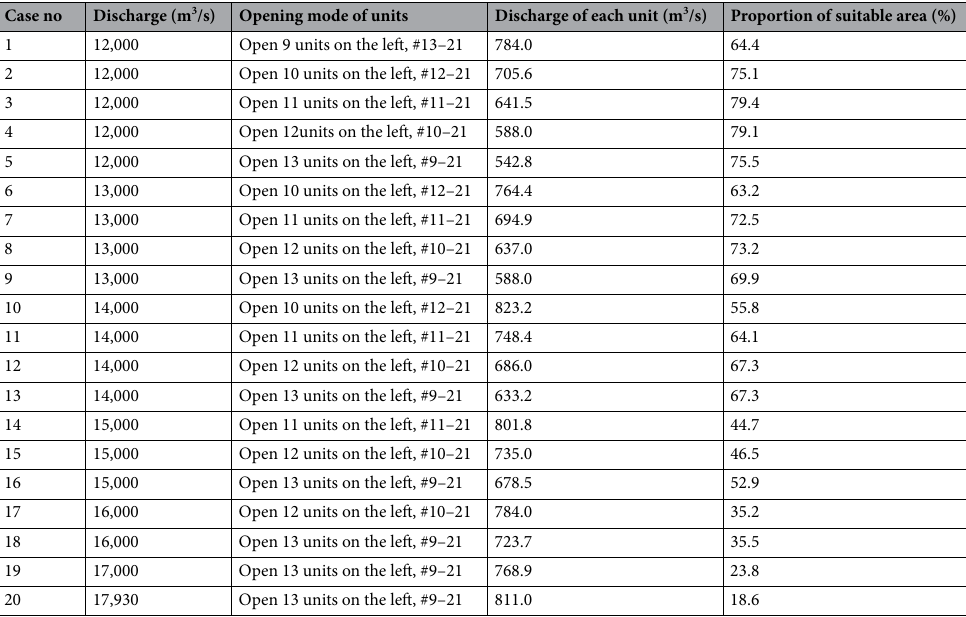
Table 3. Calculation cases with different opening modes under high-flow